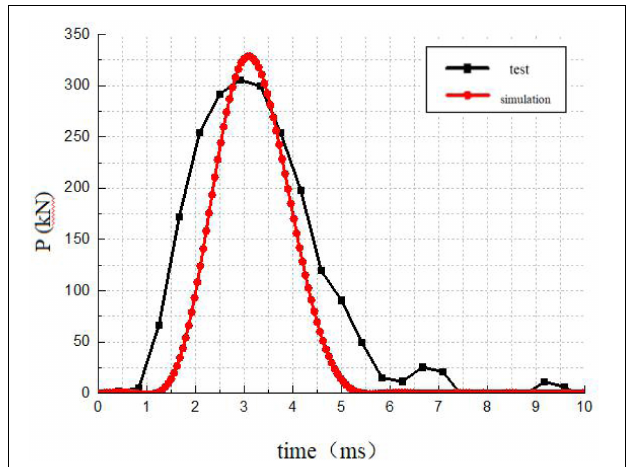
FIGURE 6 | Load time history curve.